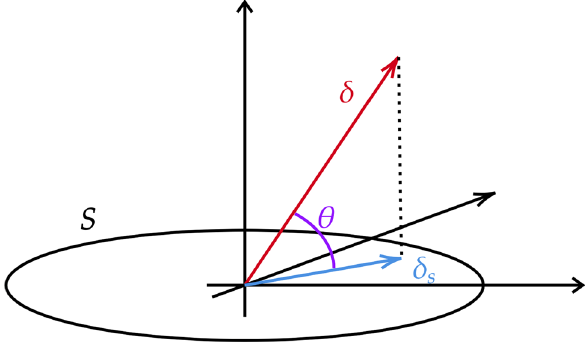
Fig. 8 Schematic representation of the geometric relation between the shift vector δ ∈ D (here drawn as a three dimensional space), and the component δ S of the shift vector which lies in the subspace S (here drawn as a two dimensional space, containing the ellipse E defined by the theory covariance matrix). The angle θ between δ and δ S is also shown: the dotted line shows the other side of the triangle, δ miss ∈ D /